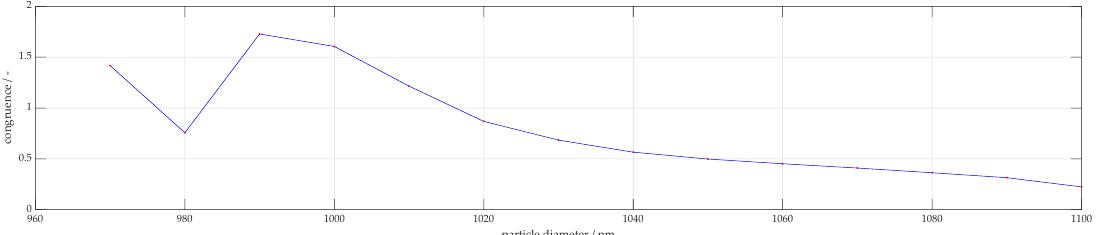
Figure 11. Particle size characterization for 1000 nm polystyrene particles after filtering simulation database for signals with similar number of local extrema. Light scatter measured in 2 ◦ increments from 20 ◦ to 160 ◦ . ( a ) Measurement and sinusoidal fit; ( b ) comparison to best fit result with 95% confidence intervals shown in gray; ( c ) comparison to actual particle size. Using the signal feature of number of local extrema allows confounding signals to be filtered out and prediction is improved.